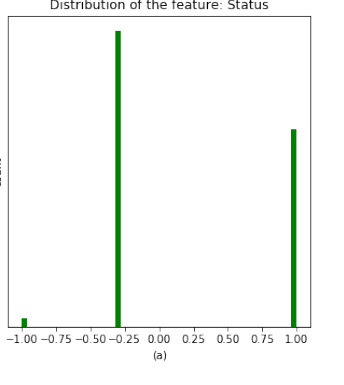
Figure 2. Bar charts of a Boolean feature ( a ) and an ordinal feature ( b ). A histogram of a quantitative feature is illustrated in ( c